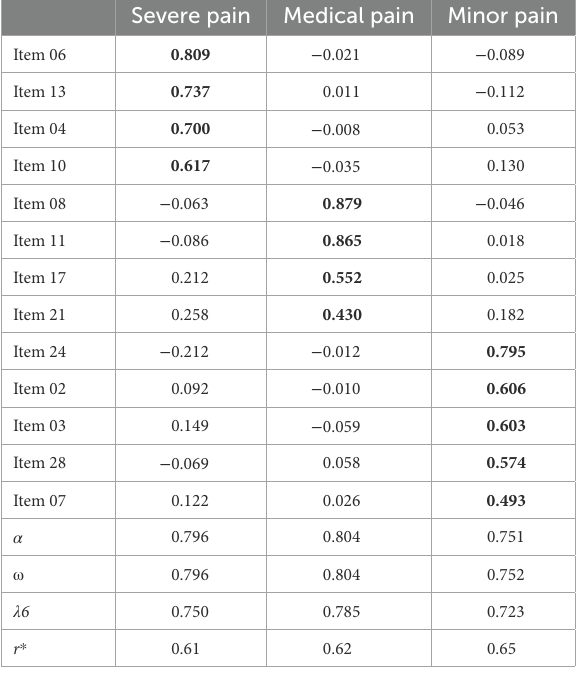
TABLE 3 Pattern matrix EFA (13 items).